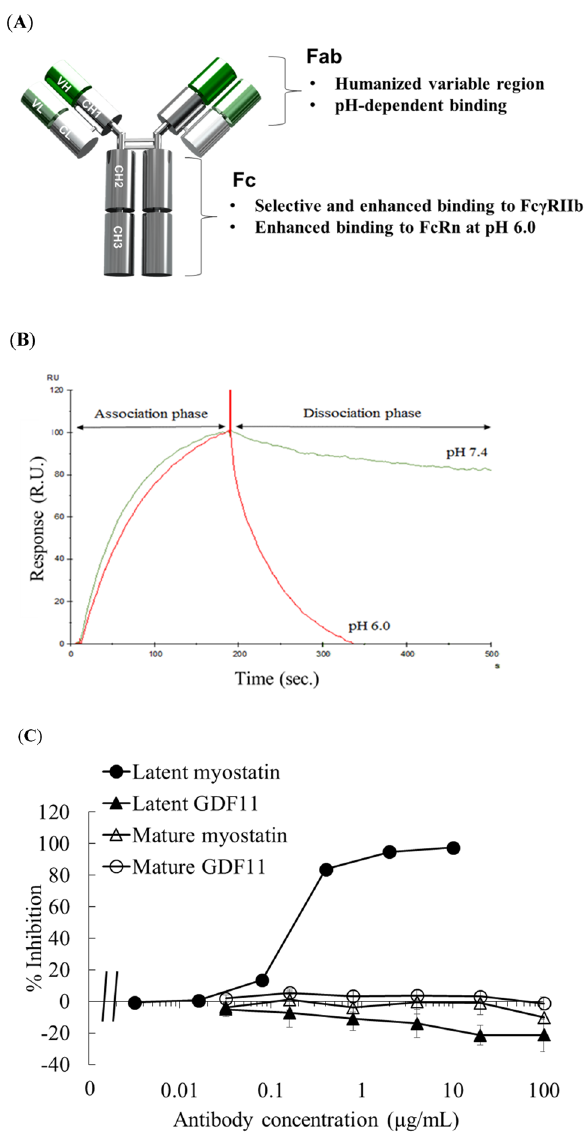
Figure 1. Generation of the anti-latent myostatin sweeping antibody, GYM329. ( A ) Summary of the characteristics engineered into GYM329. ( B ) Surface plasmon resonance analysis illustrating pH-dependent binding of GYM329 to latent myostatin. Binding of GYM329 to human latent myostatin was monitored at pH 7.4 in the association phase (0 to 180 s) and dissociation of GYM329 from latent myostatin at either pH 6.0 or 7.4 were assessed in the dissociation phase (from 180 s). The sensorgram was normalized by adjusting the latent myostatin binding response to ‘100.’ RU: resonance unit. ( C ) Inhibitory effects of GYM329 on latent myostatin, latent GDF11, mature myostatin, and mature GDF11. Latent myostatin or latent GDF11: 3 nmol/L; mature GDF11 or mature myostatin: 5 ng/mL. Mean ± SD (n =